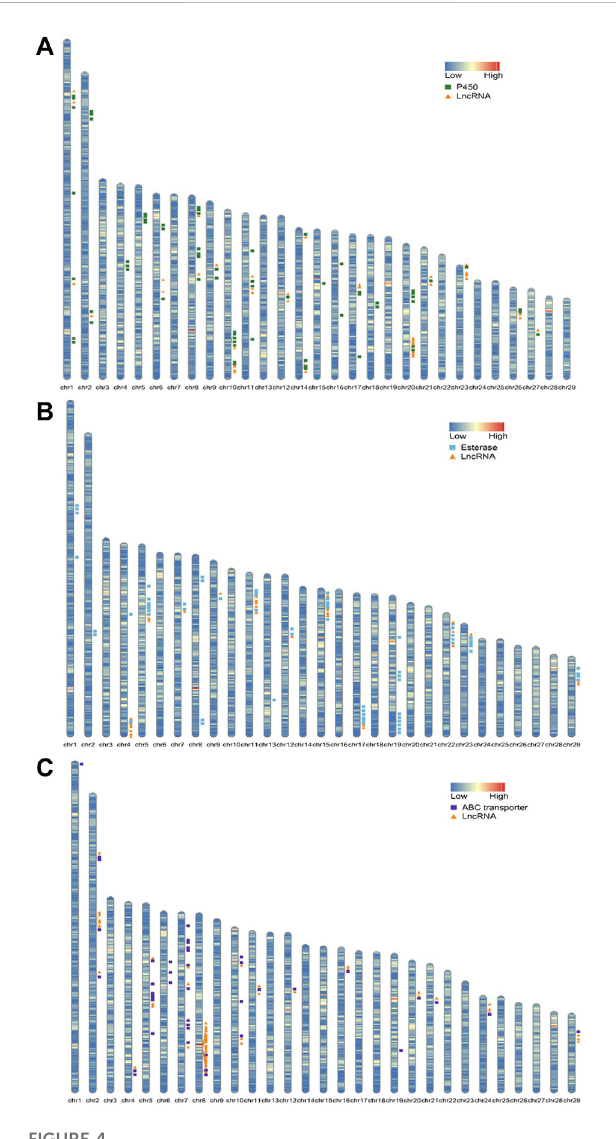
FIGURE 4 Chromosome maps showing the location of genes related to detoxi fi cation metabolic enzymes and dysregulated lncRNAs which were adjacent within 1000 kb. (A) P450 genes and dysregulated lncRNAs. (B) Esterase genes and dysregulated lncRNAs. (C) ABC genes and dysregulated